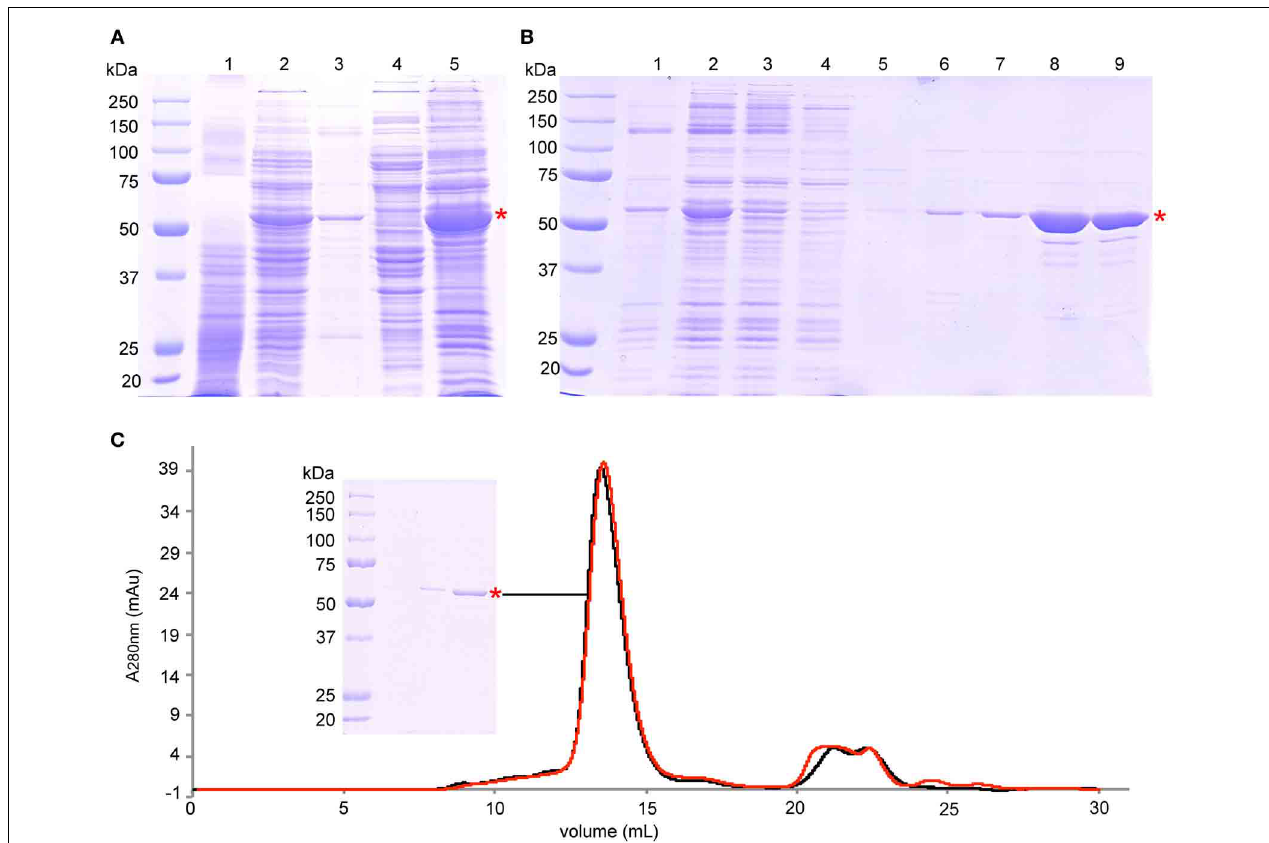
FIGURE 1 | Purification of BmrA. (A) SDS-PAGE analysis of protein expression and membrane preparation: lane 1—cell lysate before induction, lane 2—cell lysate after 6h of overexpression, lane 3—pellet after centrifugation at 15,000 × g, lane 4—supernatant after centrifugation at 193,000 × g, lane 5—isolated membranes after centrifugation at 193,000 × g. (B) SDS-PAGE analysis of protein solubilization and purification steps on Ni-NTA Agarose: lane 1—pellet after solubilization and centrifugation at 98,000 × g, lane 2—supernatant after solubilization and